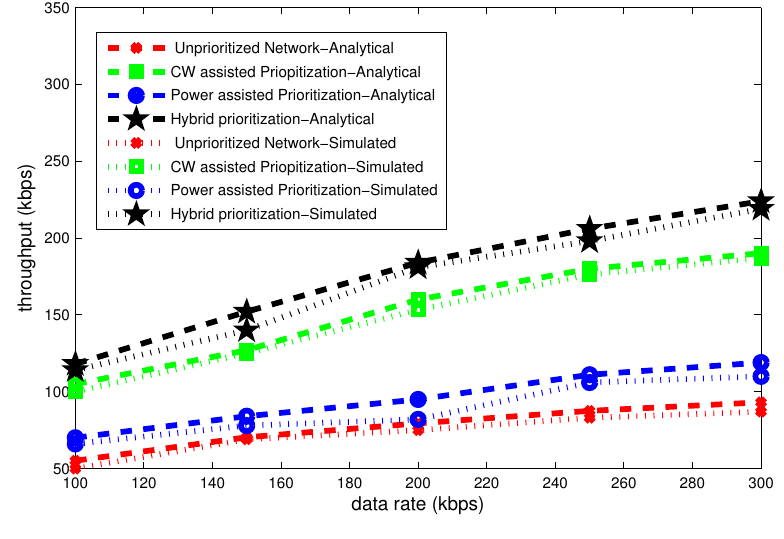
Figure 15. Effect of data rate on throughput.